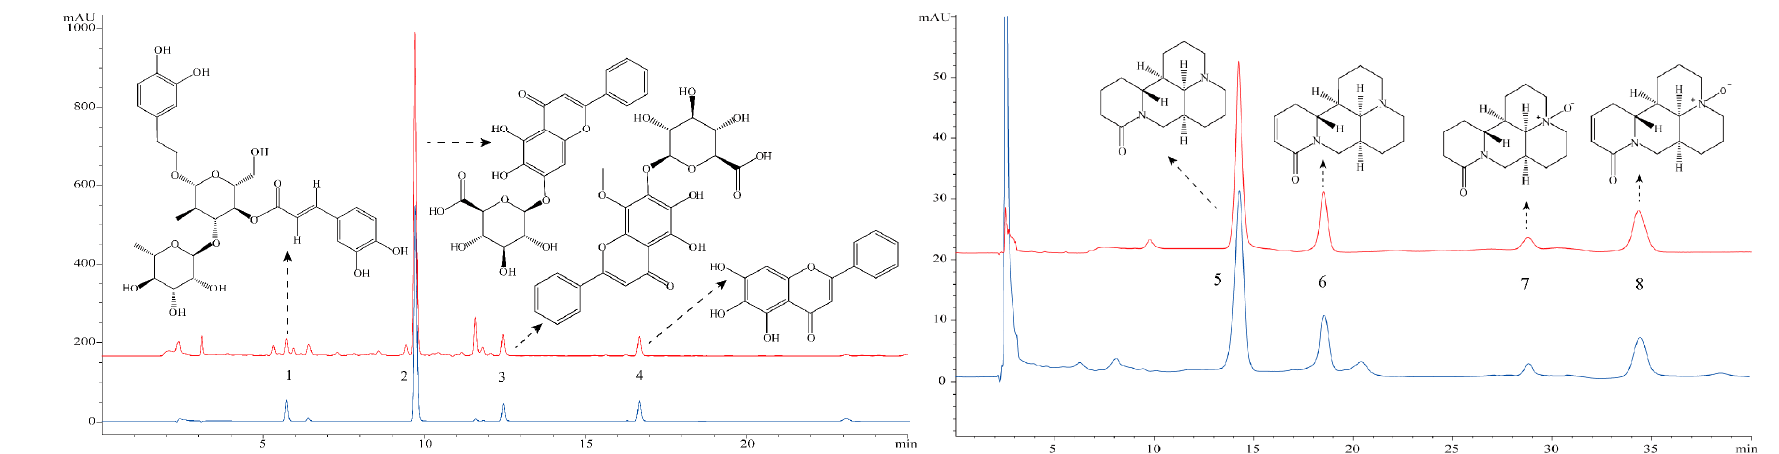
Figure 1. Identification analysis of acteoside (1), baicalin (2), wogonoside (3), baicalein (4), matrine (5), sophocarpine (6), oxymatrine (7), and oxysophocarpine (8) in SWHD by HPLC-DAD in comparison with standard reference compounds. The red colors are represented standard substances and the blue colors are represented samples.